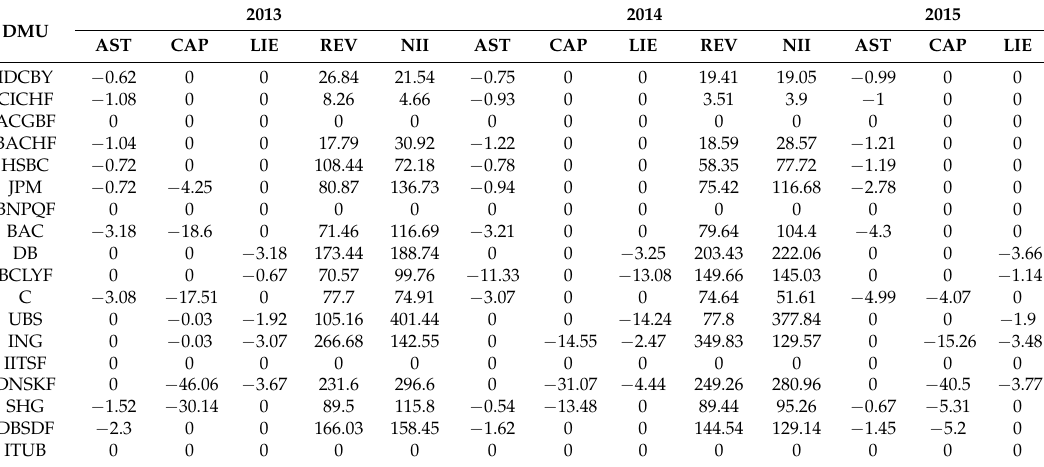
Table A3. Projections of large banks for